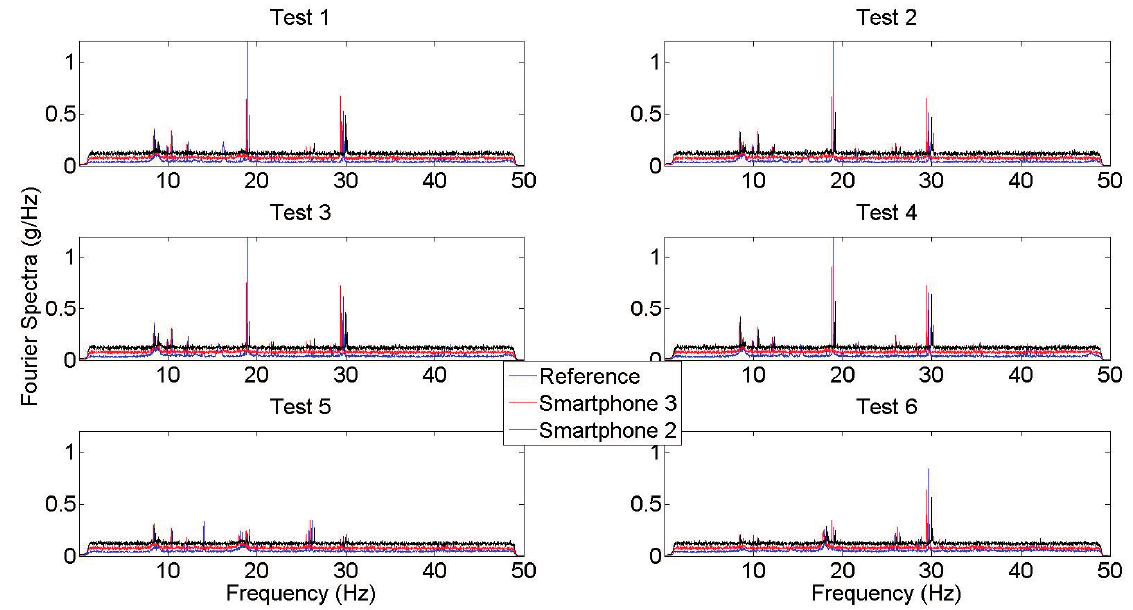
Figure 8. Fourier spectra from the average of 40 samples for Test